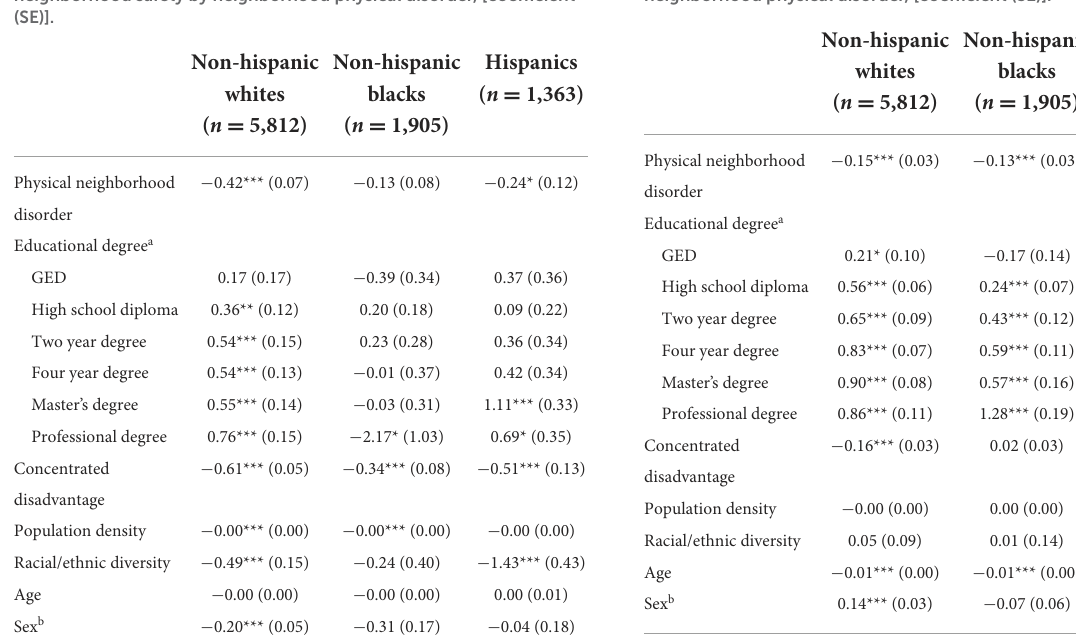
TABLE 3 Weighted linear regressions predicting self-rated health by neighborhood physical disorder, [coefficient